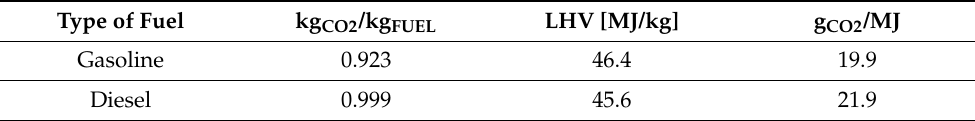
Table 4. GHG emissions for fossil fuels production process (Data source